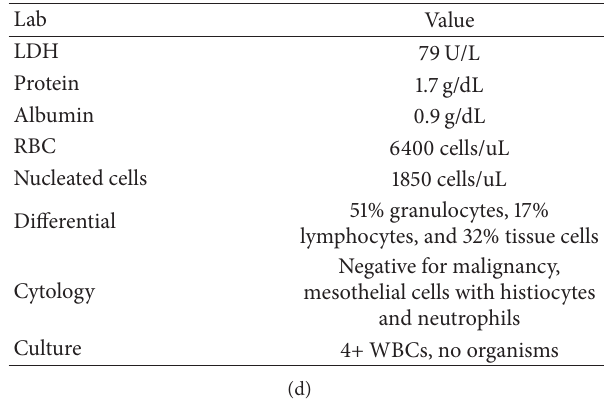
Table 1: (a) Initial labs. (b) Other labs. (c) Paracentesis. (d) Urine